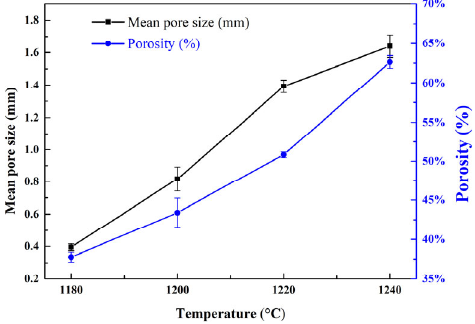
Figure 5. Mean pore size and porosity of samples sintered at different temperatures for 20